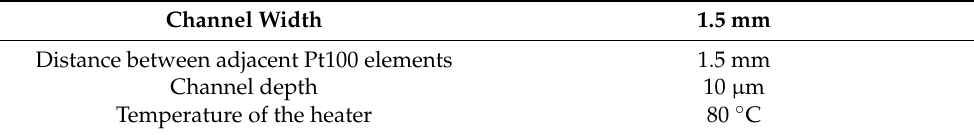
Table 2. Crucial design and temperature prototype parameters.